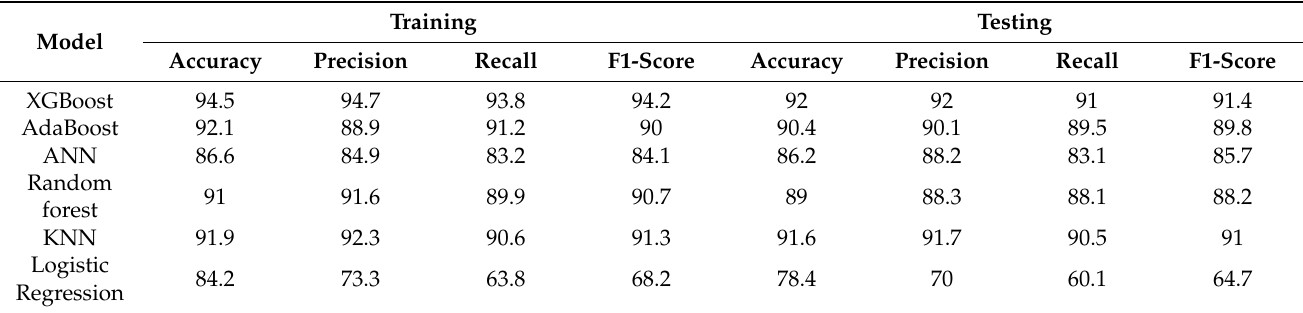
Table 3. Summary of the results obtained by various machine learning models used in this research (in percentage).